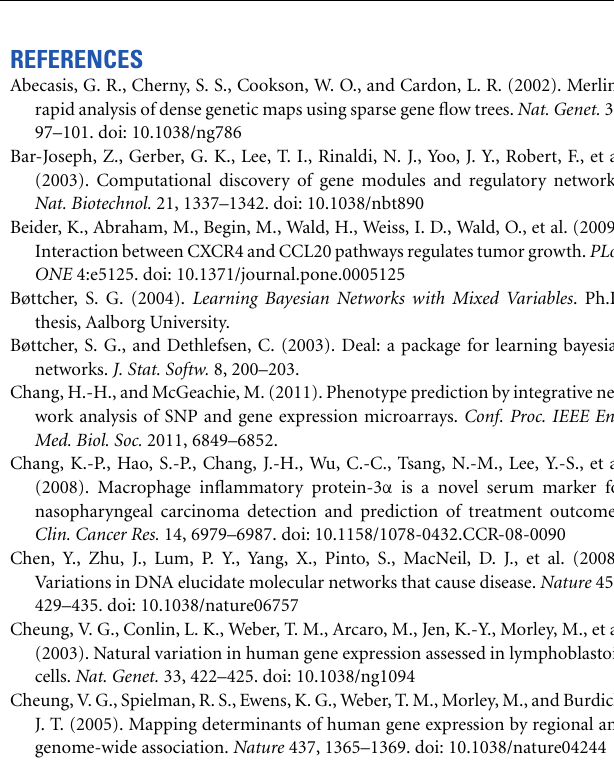
FIGURE 12 | Top scoring five-node network structures for 5-FU reported from nPARS algorithm.